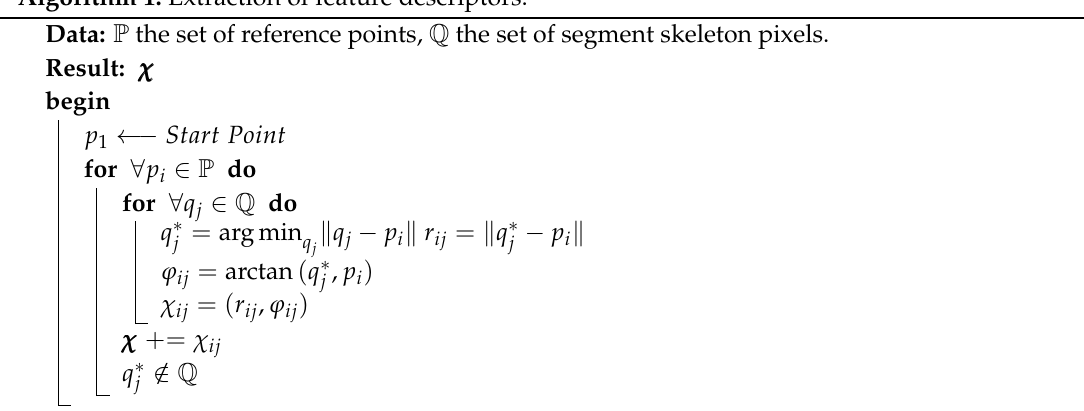
Figure 1. Extraction of features descriptors: ( a ) extracted features computation; ( b ) segmented handwritten word; ( c ) clockwise features; and ( d ) anticlockwise features. Algorithm 1: Extraction of feature